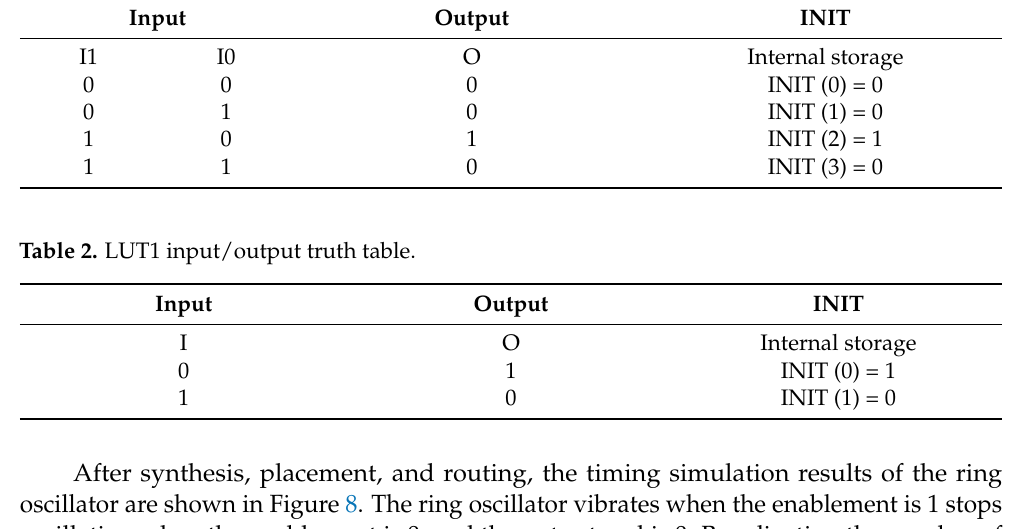
Table 1. LUT2 input/output truth table.